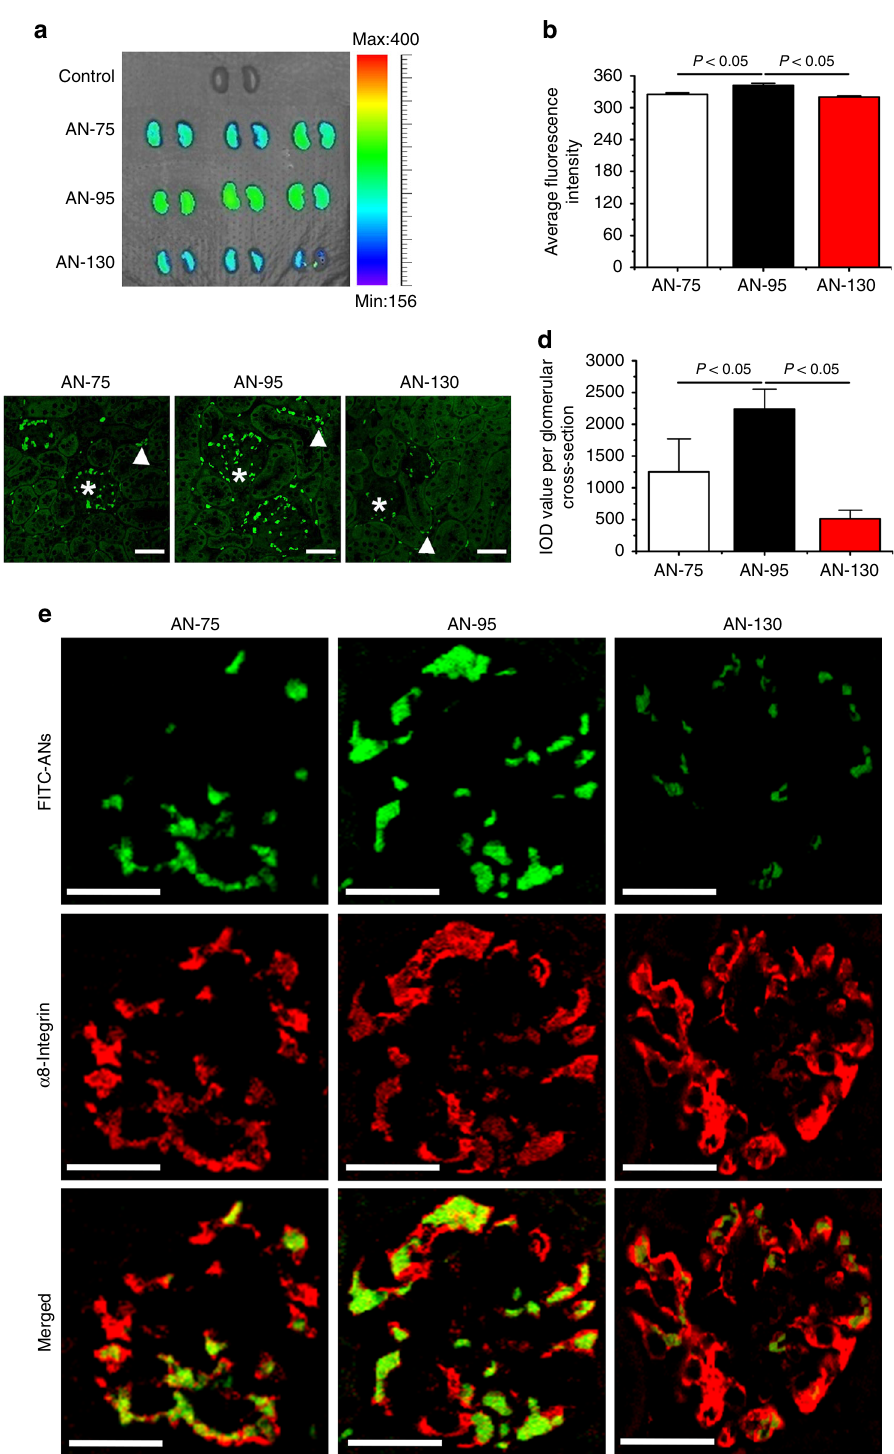
Fig. 3 FITC-ANs size-dependently localize at the glomerular mesangial cells. a In vivo fl uorescence images of kidneys excised at 5 min after tail vein injection of FITC-ANs. b Semiquantitative fl uorescence intensity of excised kidneys in a . c Representative confocal images of kidney tissue sections taken at 5 min after tail vein injection of FITC-ANs. * and Δ mark glomeruli and peritubular interstitial space, respectively. Scale bars , 30 μ m. d Integrated optical density ( IOD ) per glomerular cross-section representing the fl uorescence intensity and spread of FITC-ANs in glomerulus as analyzed by cellSens Standard digital imaging software (Olympus). For each treatment group AN-75 to AN-130, 150 glomeruli were analyzed. In panels b , d data are mean ± s.d. ( n = 3), results are representative of two independent experiments. Statistical signi fi cance was determined by one-way ANOVA with Tukey post hoc test. e Representative confocal images of FITC-ANs localization at glomerular mesangial cells. Kidney tissue sections obtained at 5 min after tail vein injection of FITC-ANs ( green ) were counter-stained with NL637 conjugated antibody against the mesangial marker α 8-integrin ( red ). Scale bars , 30 μ